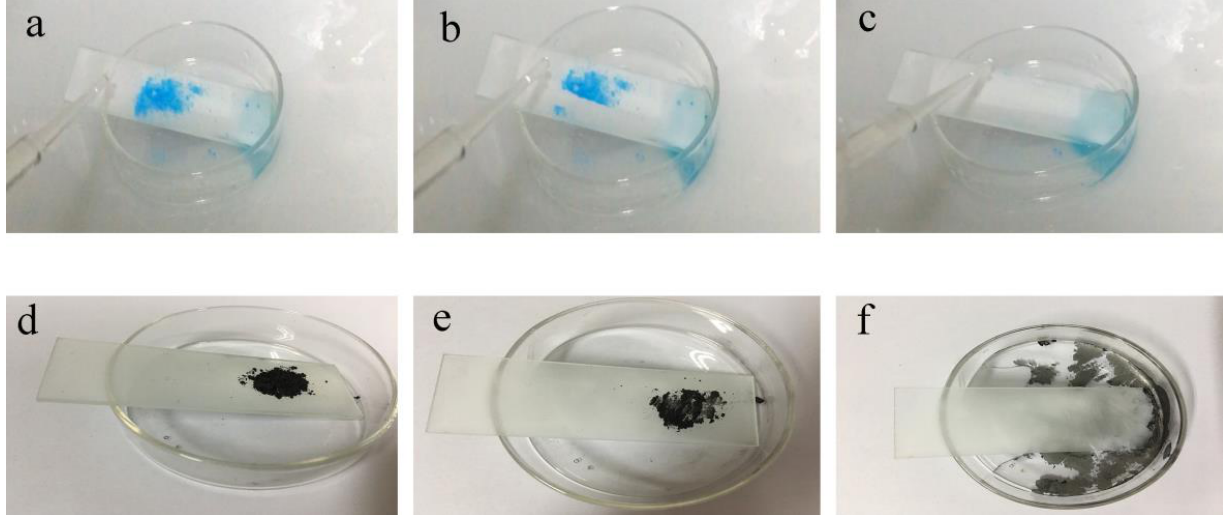
Figure 12. Self-cleaning behavior of FEP-S coating using ( a – c ) CuSO 4 powder and ( d – f ) carbon black powder as contaminants.